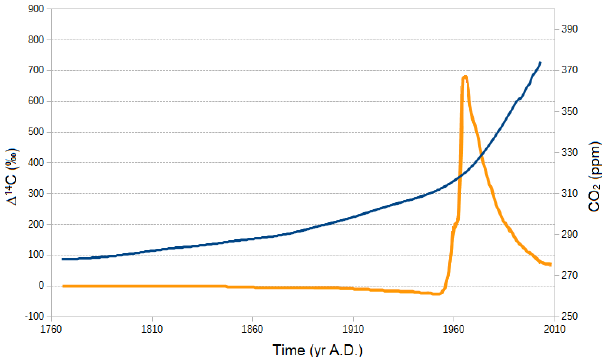
Figure 1. Atmospheric (cid:49) 14 C in‰ (orange) and atmospheric CO 2 in ppm (blue) from (Orr et al., 2016) and references cited